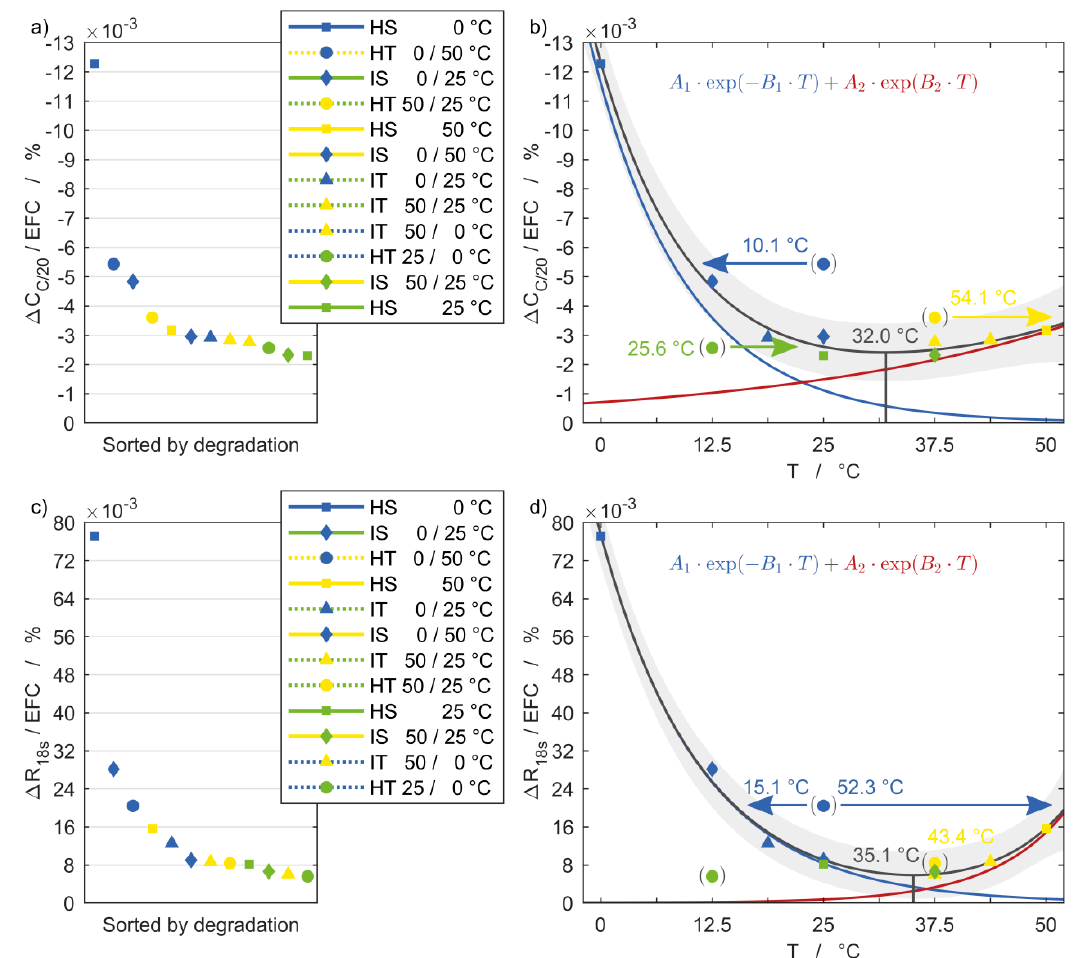
Figure 7. ( a , b ) Discharge capacity fade and ( c , d ) current pulse resistance degradation with reference to equivalent full cycles and in relation to the corresponding equivalent aging temperature of each setup including 95% confidence intervals.